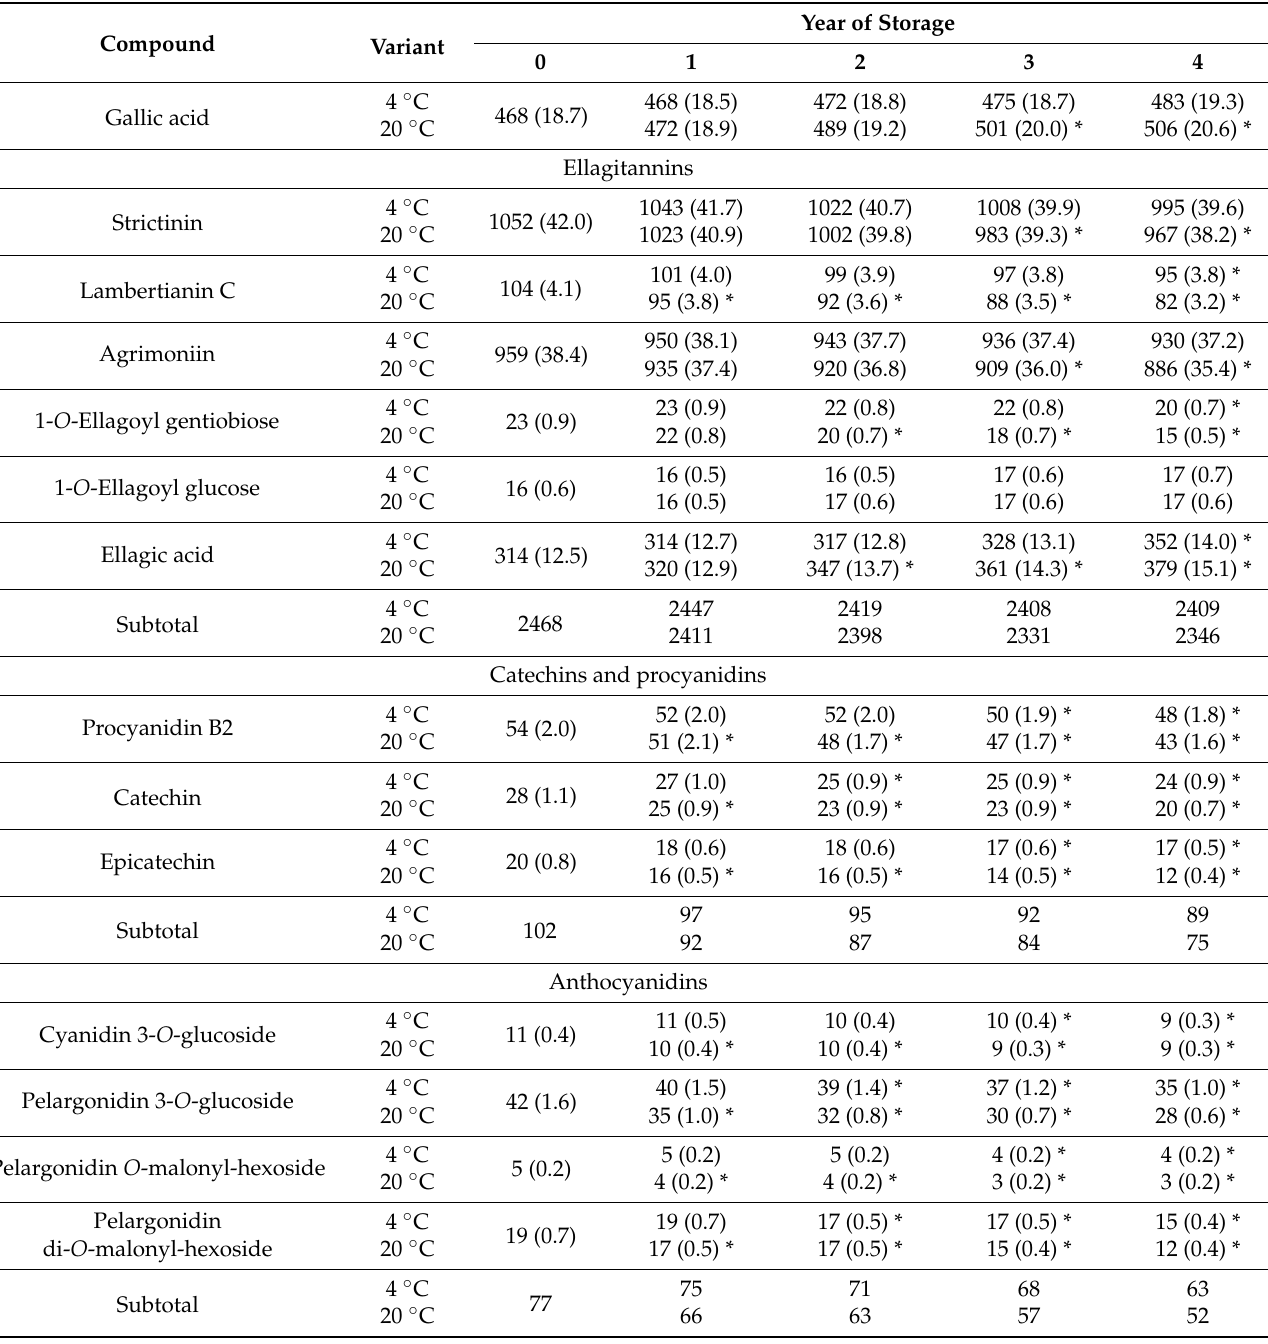
Table 7. Content of 20 phenolic compounds and ascorbic acid (mg/100 g dry weight) and